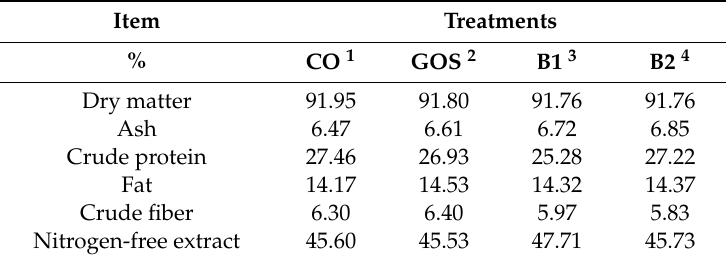
Table 1. Chemical composition of the experimental